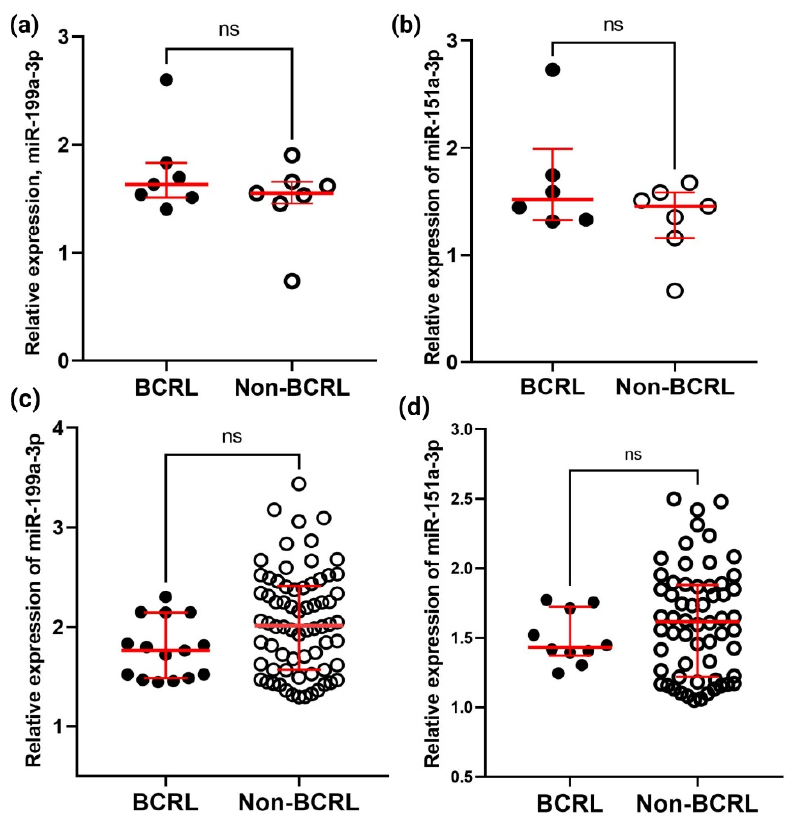
Figure 4. Relative expression of miR-199a-3p and miR-151a-3p in the discovery and combined cohort as measured by qPCR. Relative expression of the miRNAs was calculated using the 2 −∆∆ Ct method and were compared between the BCRL and non-BCRL groups. ( a ) The expression of miR-199a-3p and ( b ) miR-151a-3p were validated in the discovery cohort (BCRL, n = 7 and non-BCRL, n = 7); ( c ) the relative expression of miR-199a-3p and ( d ) miR-151a-3p in samples of the validation cohort. Open dots represent BCRL cases ( n = 16) and black dots represent cases in the non-BCRL group ( n = 90). Data were normalized to an endogenous control, miR-16-5p. All samples were analyzed in triplicate. p -values were calculated using Mann–Whitney test ( p < 0.05), with ns denoting a non-significant difference. Results are expressed as the median and error bars denote interquartile range or IQR.